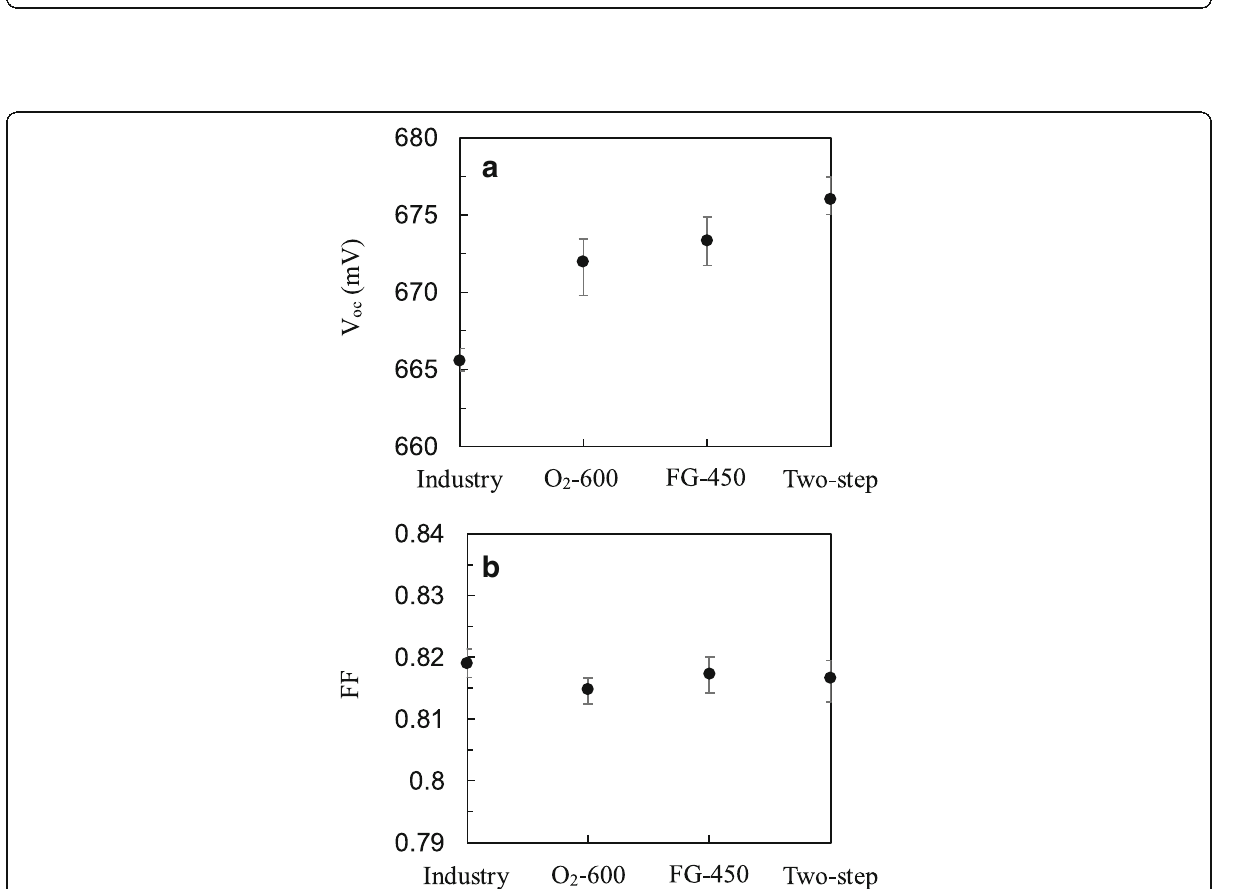
Fig. 8 Mean value and distribution range of a V oc and b FF for PERCs with different annealing